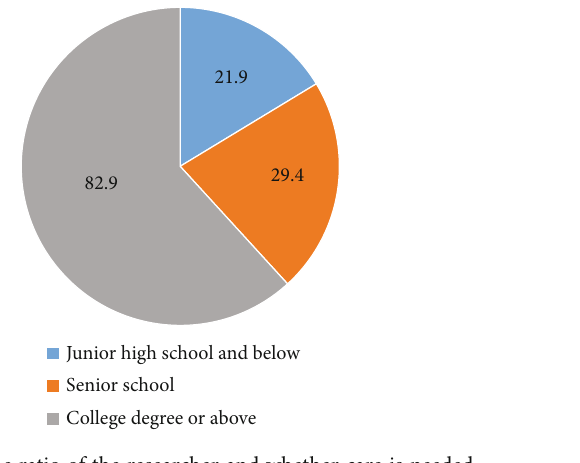
Figure 1: The ratio of the researcher and whether care is needed.